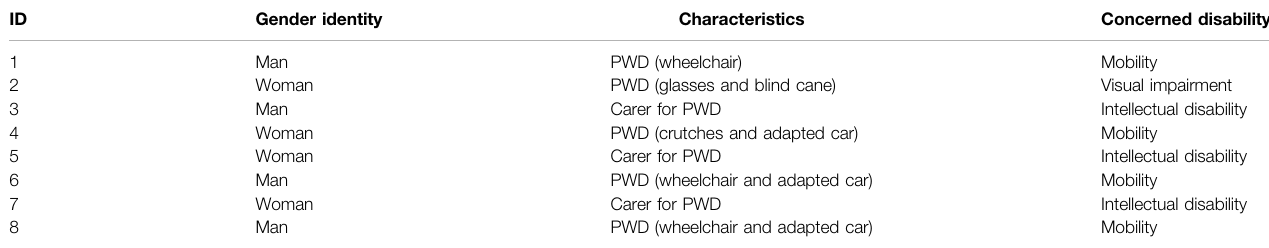
TABLE 1 | List of